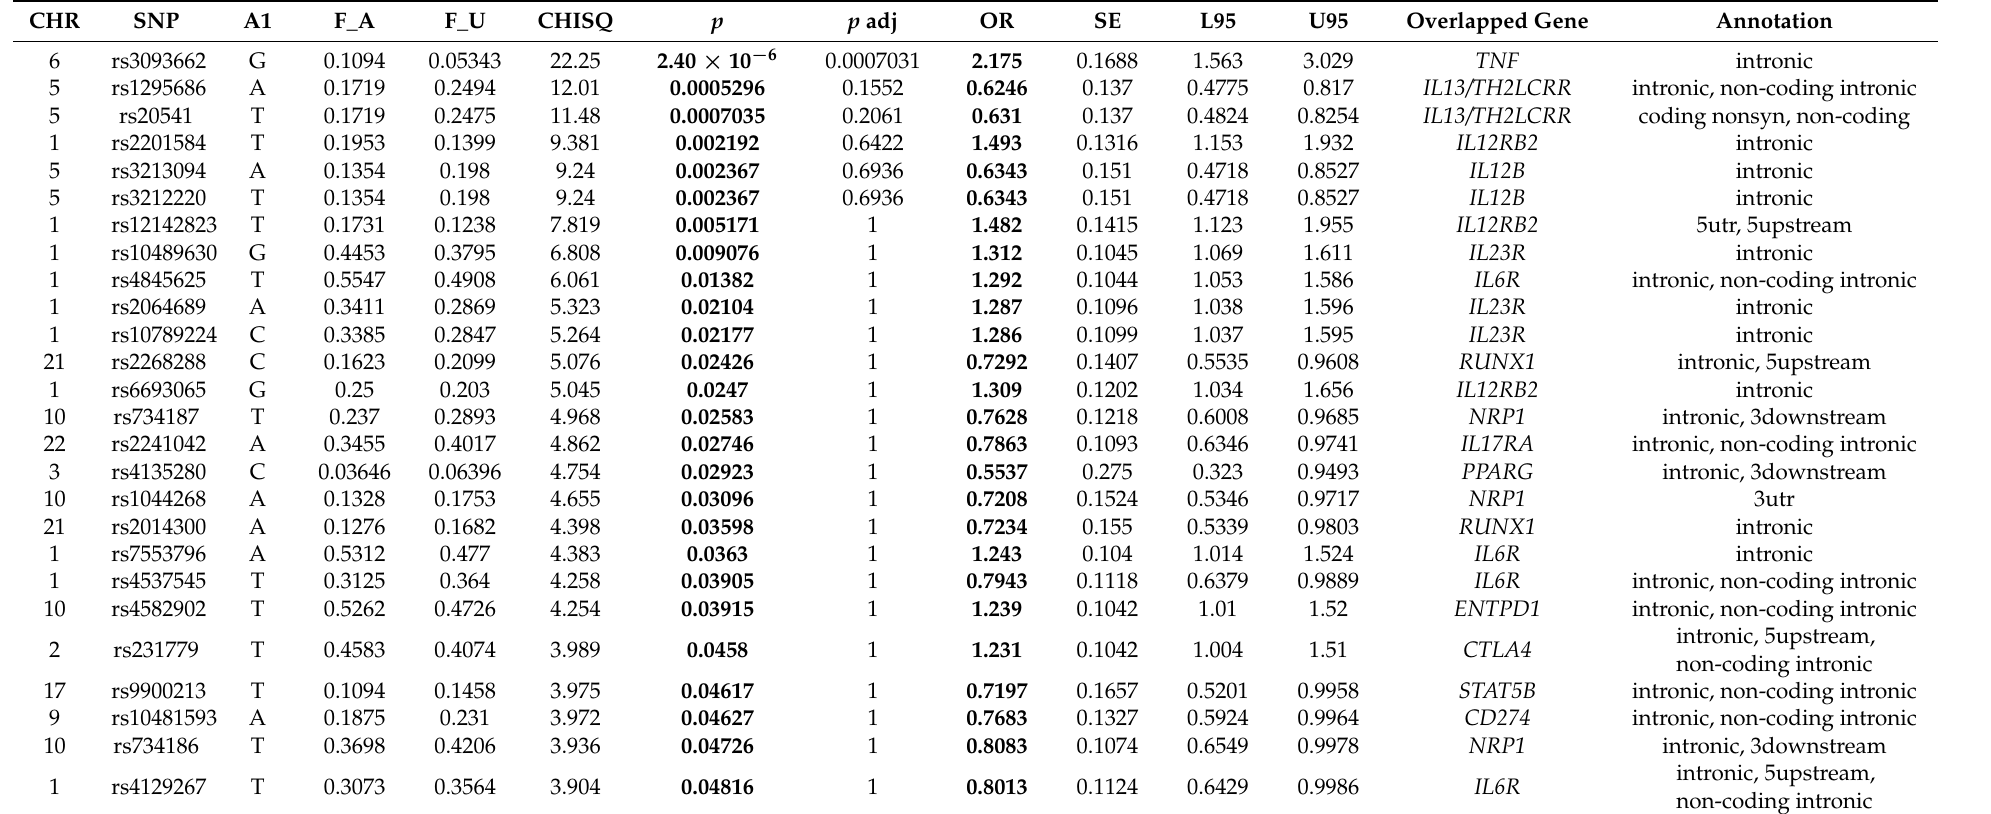
Table 1. Comparison of the allele frequency of SNPs in PsO patients and